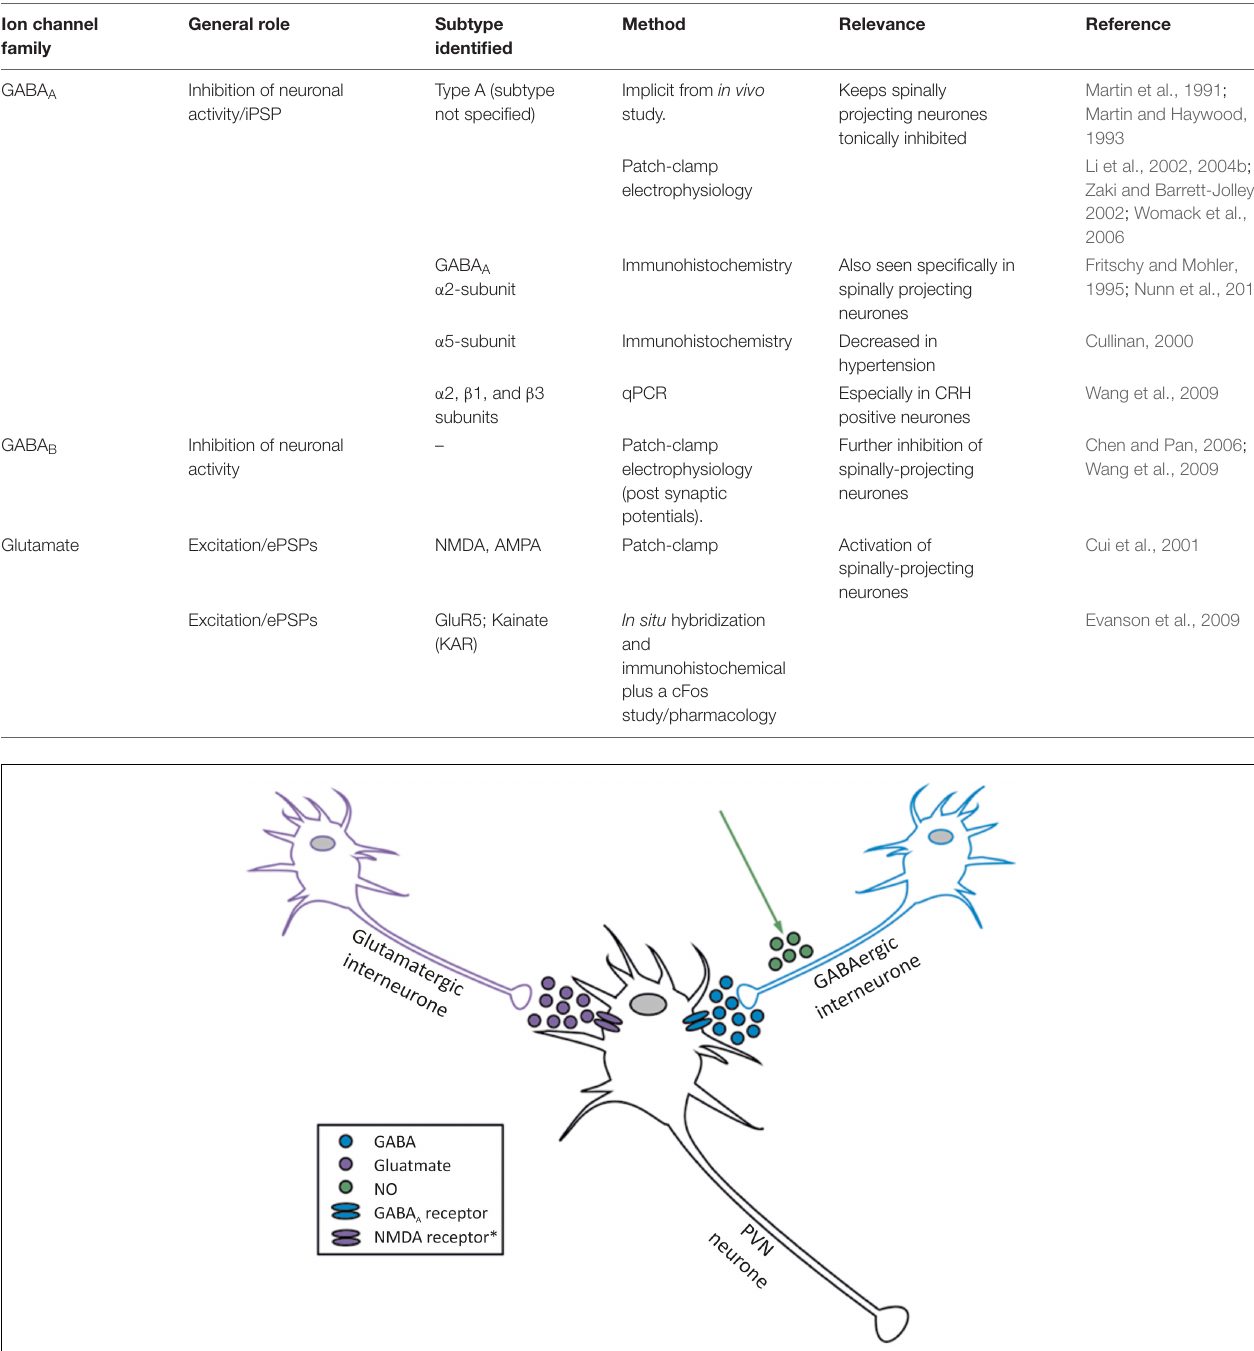
potential (TRP) ion channels. The TRP multigene superfamily encodes a family of 28 ion channels that are conserved in yeast, invertebrates and vertebrates. The TRP family is divided into